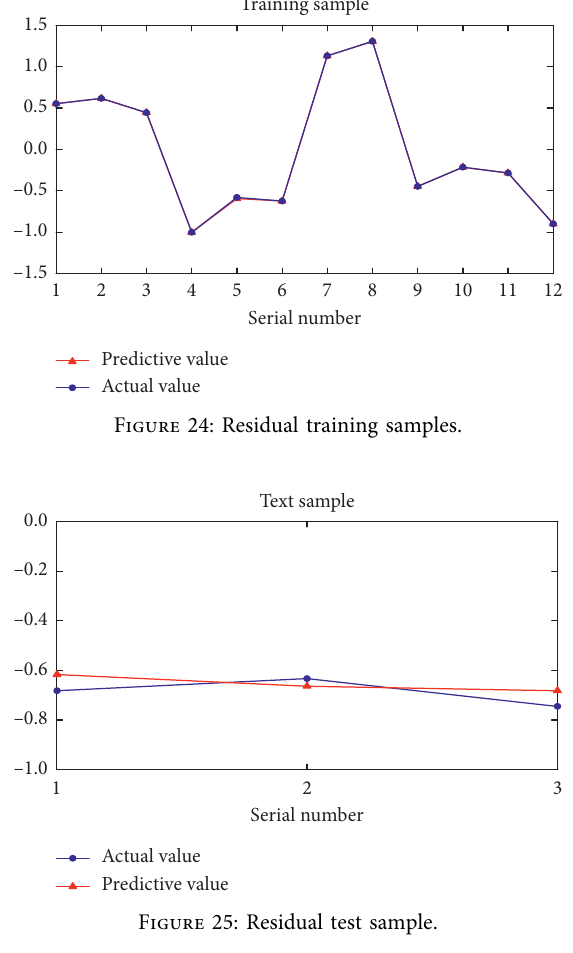
Figure 25: Residual test sample.